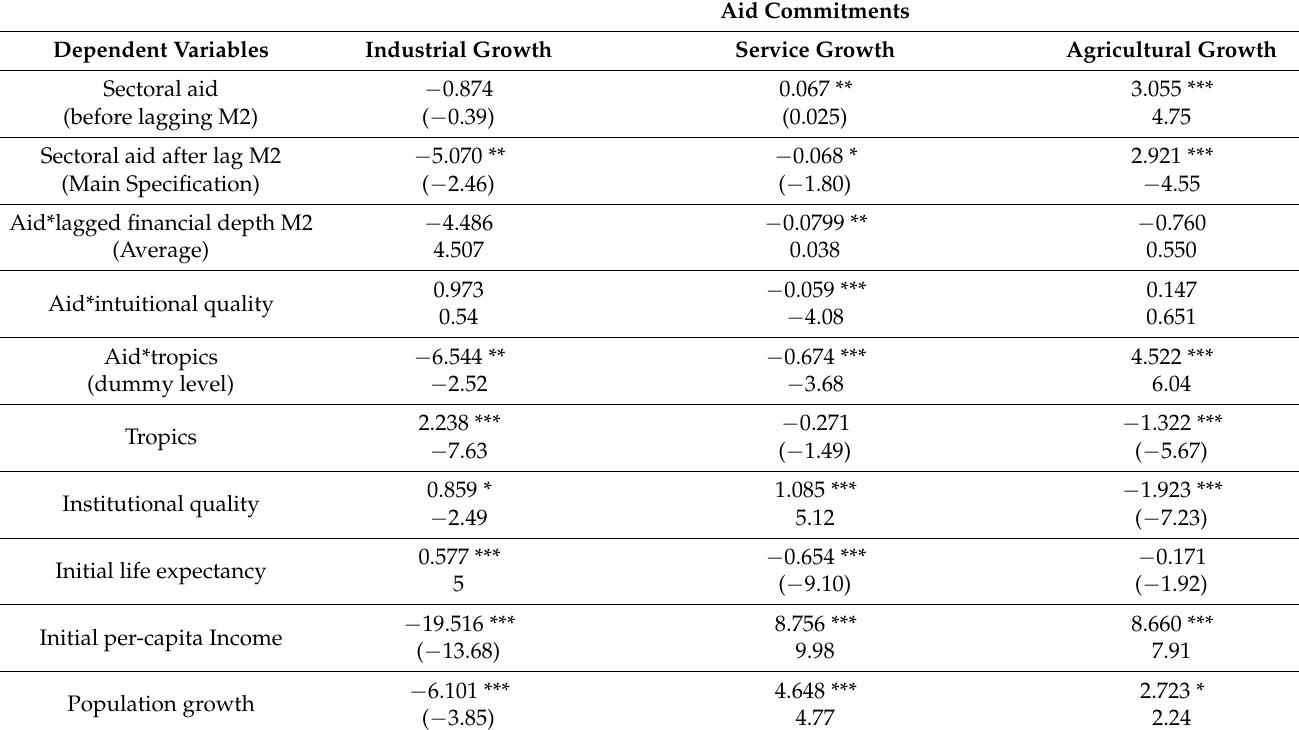
Table 3. Estimation results for the second specification (standard aid–growth